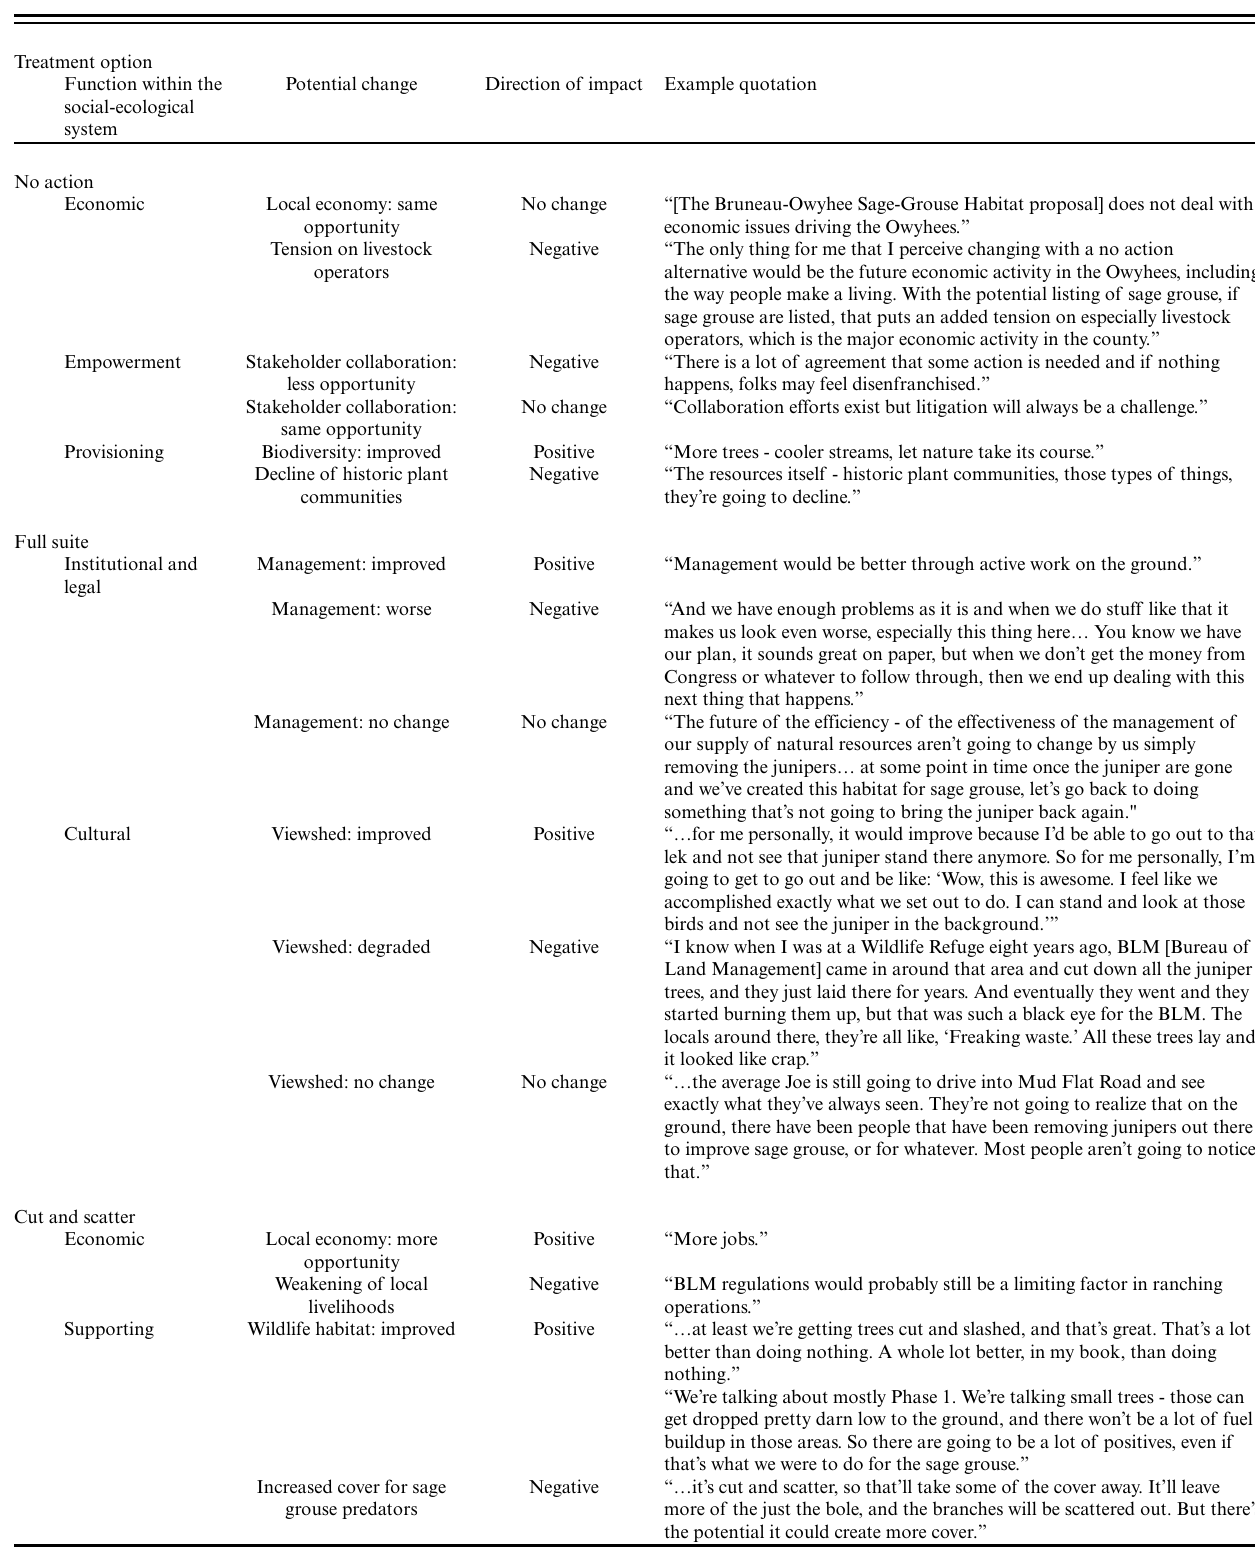
Table 2. Potential changes to social processes and ecosystem services with associated direction of impact as described by workshop participants, with example quotations. Sixteen examples are provided here to illustrate complexity and nuances in perceptions and descriptions collected during workshops. See Appendix 1 for all 46 potential changes and